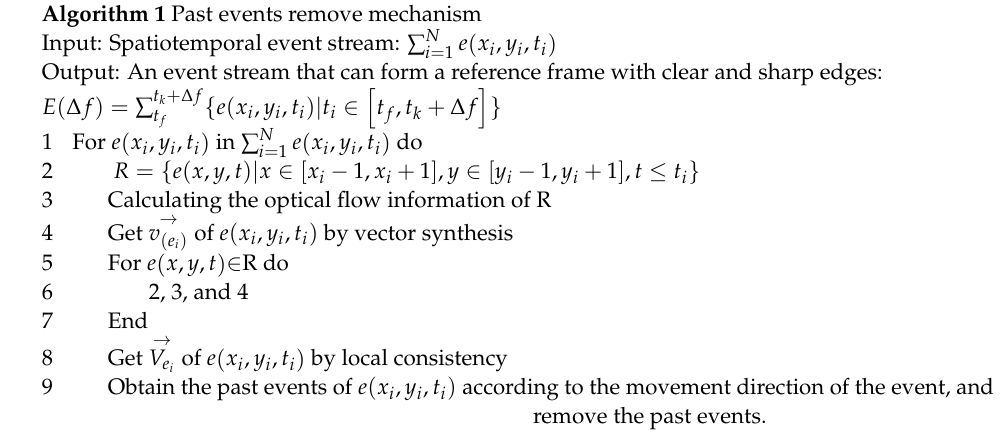
Algorithm 1 Past events remove